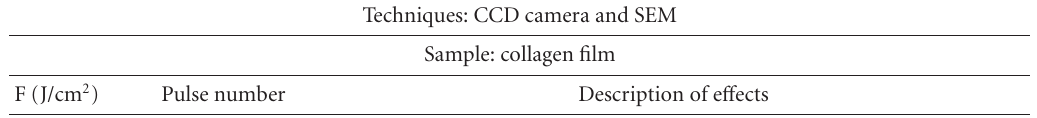
Table 1: Experimental conditions and the e ff ects of KrF laser irradiation on the studied film surfaces. Techniques: CCD camera and